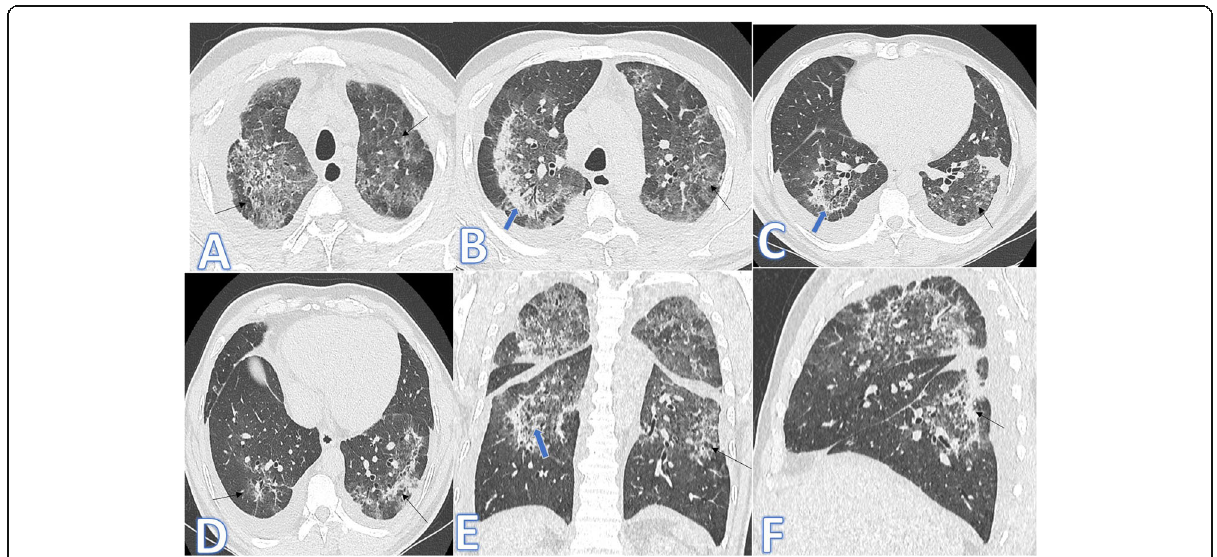
Fig. 6 A 61-year-old male patient presented with cough and fever. CT chest showed multifocal GGO, crazy paving and consolidation with Atoll sign (blue arrows) more in the upper lobes with subpleural sparing and bilateral pleural effusions more on the right side (arrow in d ). The